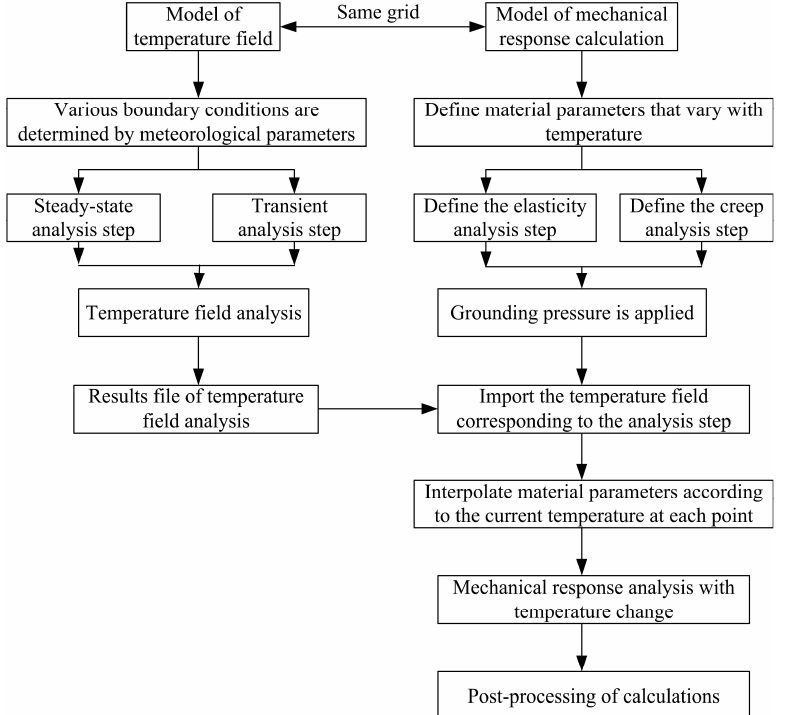
Figure 5. Principles and procedure of analysis method for mechanical characteristics of BRT asphalt pavement structure under varying temperatures and bus loads.